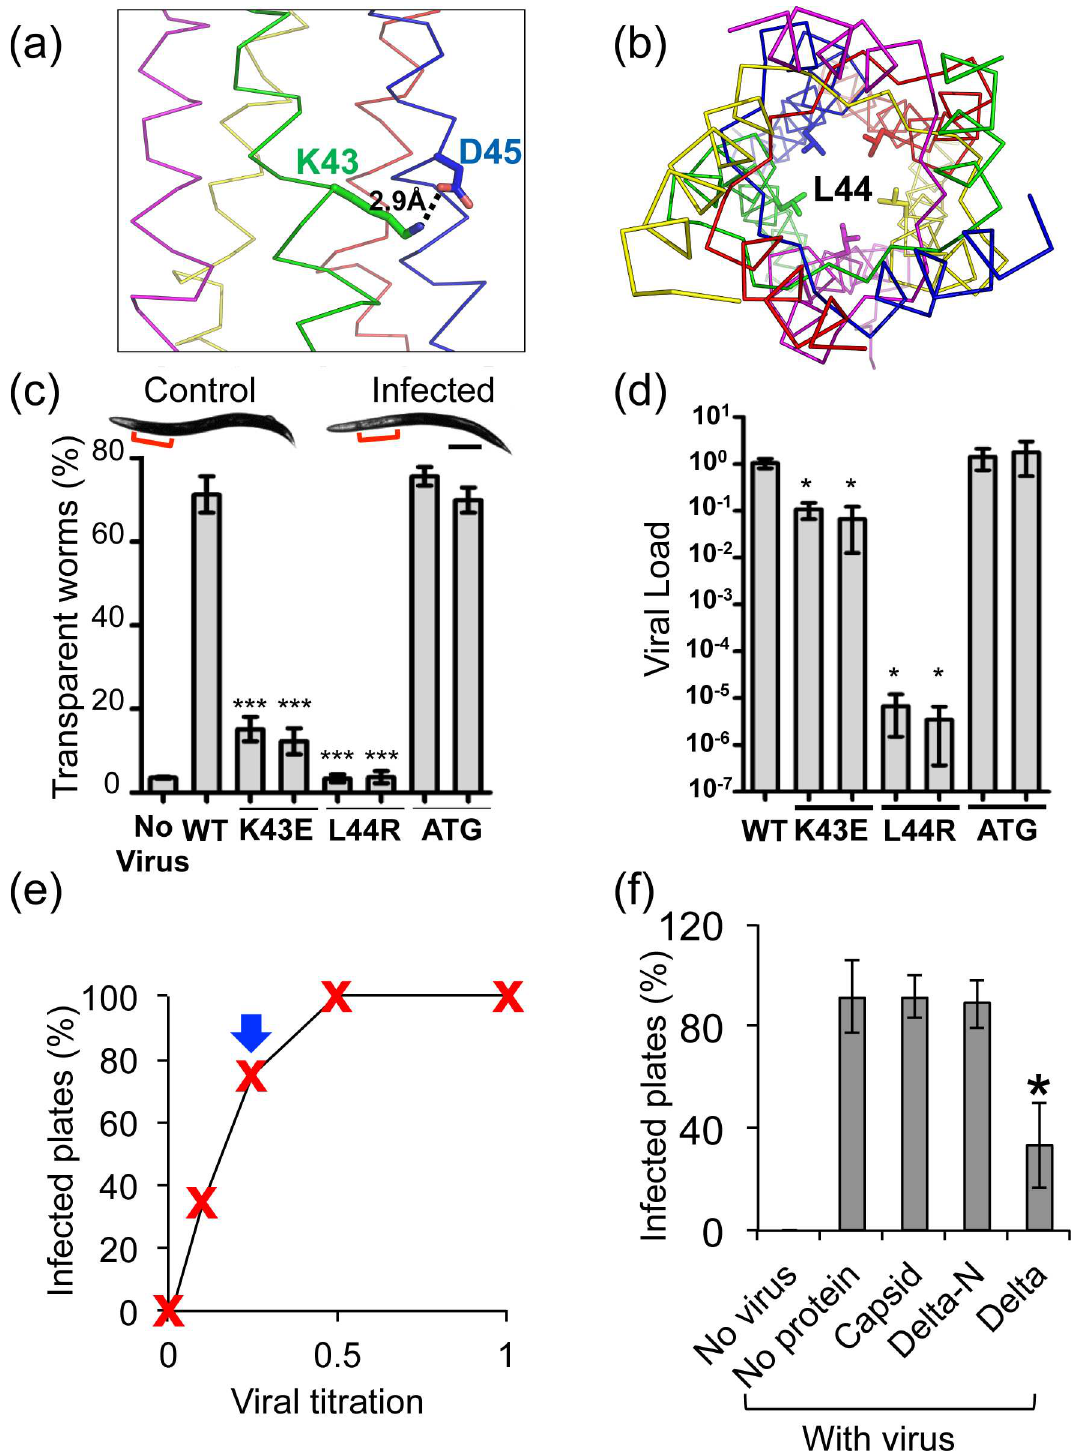
Fig 6. Site-directed mutagenesis and infectivity assays. (a) K43 forming a salt bridgewith D45. Only a portion of the structure is shown. (b) L44 facing the hydrophobicinterior of the helicalbundle.(c) Transparency test for wild-type(WT) and mutant Orsay viruses. As displayedin the inset, Orsay-infected worms, but not the control, show a transparentintestine particularly at the anterior regionas indicatedby red brackets. Scale bar, 100 μ m. (d) Viral load of wild-typeand mutant viruses measuredby qRT-PCR. In (c-d), two independent transgeniclines for each mutant virus were tested.